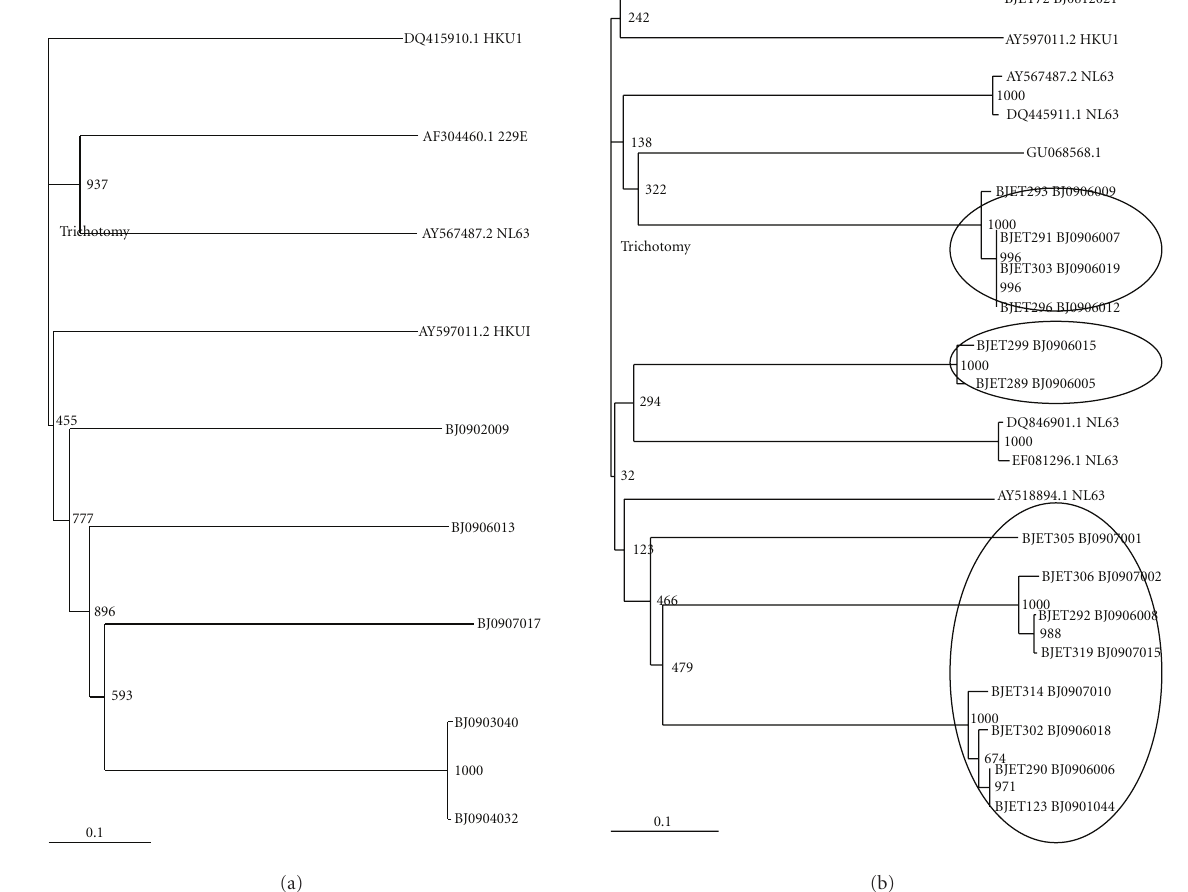
Figure 2: Phylogenetic analysis of the nt sequences of HCoV-HKU1 (a) and HCoV-NL63 (b). The N genes were amplified from positive samples collected between November 2008 and October 2009. Trees were constructed using Neighbor-Joining methods. Local HCoV strains are indicated by the designation BJ and are all from 2009. Bootstrap values are